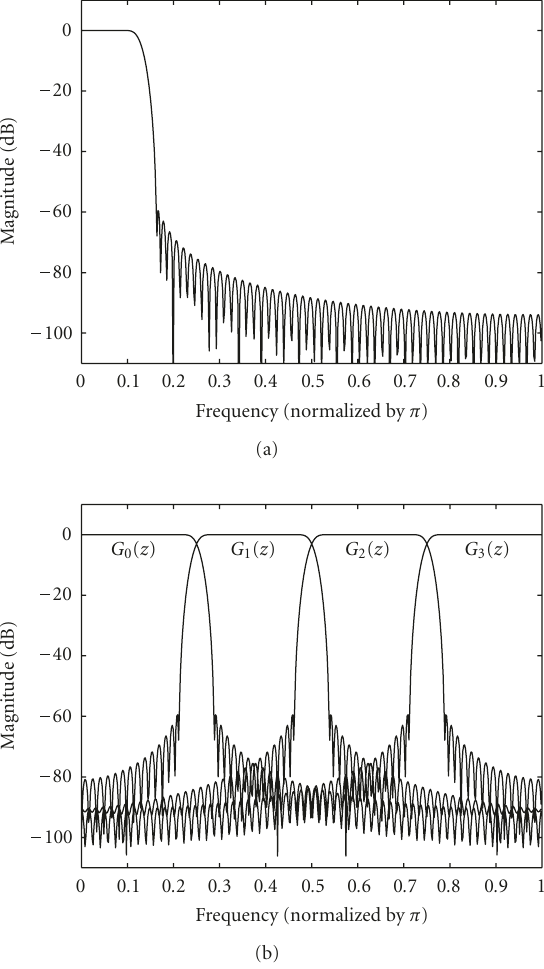
Figure 6: The magnitude responses of (a) prototype FIR filter and (b) analysis